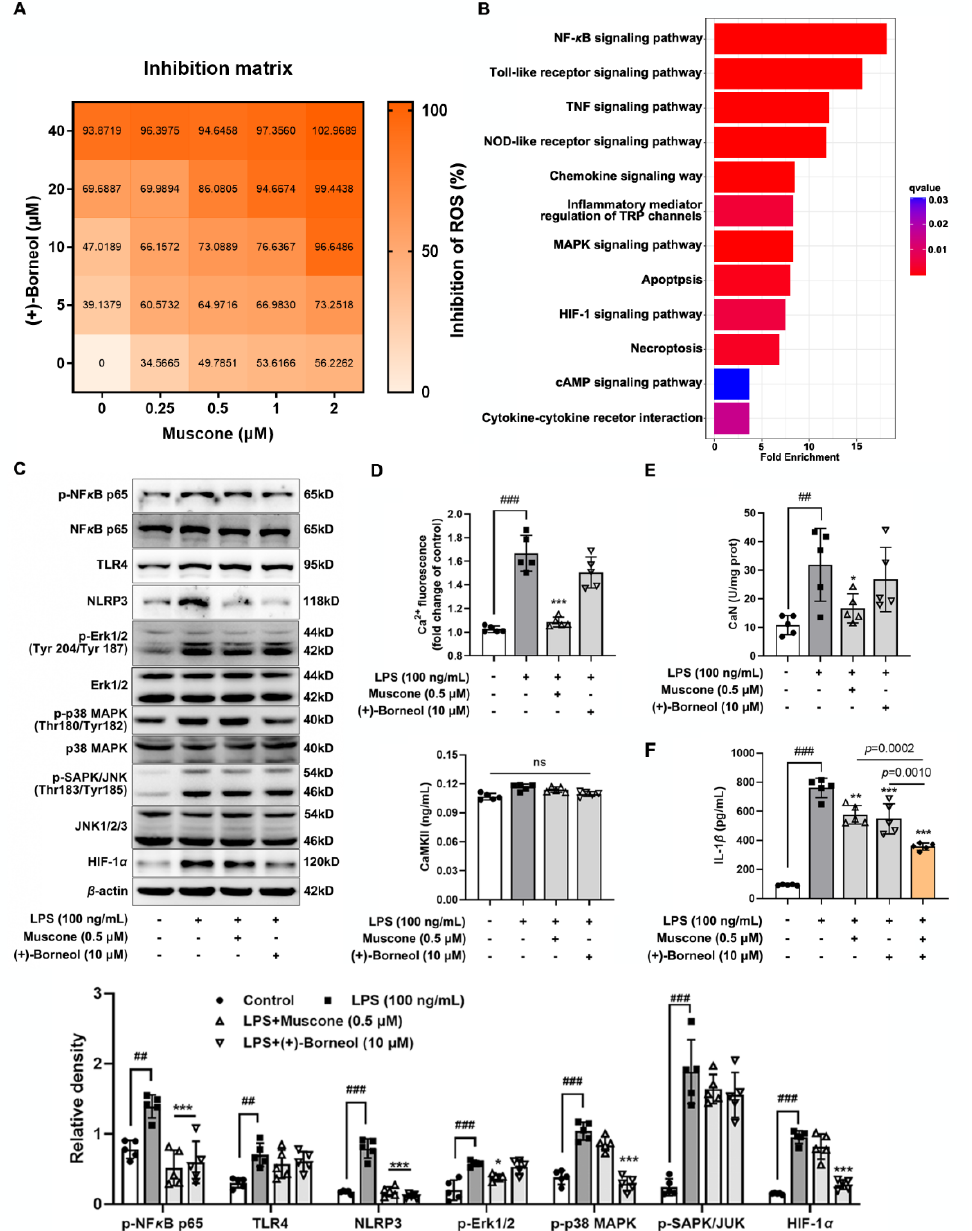
Figure 5. Muscone suppresses oxidation-stress-mediated inflammation via blocking Ca 2+ /Erk1/2 signaling pathway. ( A ) The inhibition matrix of ROS production in LPS-induced bEnd.3 cells treated with muscone (dose range from 0 to 2 μM) and (+)-borneol (dose range from 0 to 40 μM) for 16 h; ( B ) column chart of KEGG pathway enrichment analysis of IL-1 β -related genes pulled from the human interactome; ( C ) p-NF- κ B p65, NF- κ B p65, TLR4, NLRP3, p-Erk1/2, Erk 1/2, p-p38 MAPK, p38- MAPK, p-SAPK/JNK, JNK1/2/3, and HIF-1 α protein expression were determined in LPS-induced bEnd.3 cells ( n = 5); ( D ) relative fluorescent density of intracellular Ca 2+ indicated by Fluo